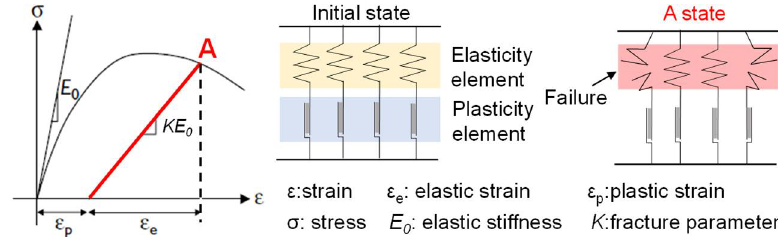
Figure 1. Mechanical model for elastic-plastic damage of concrete